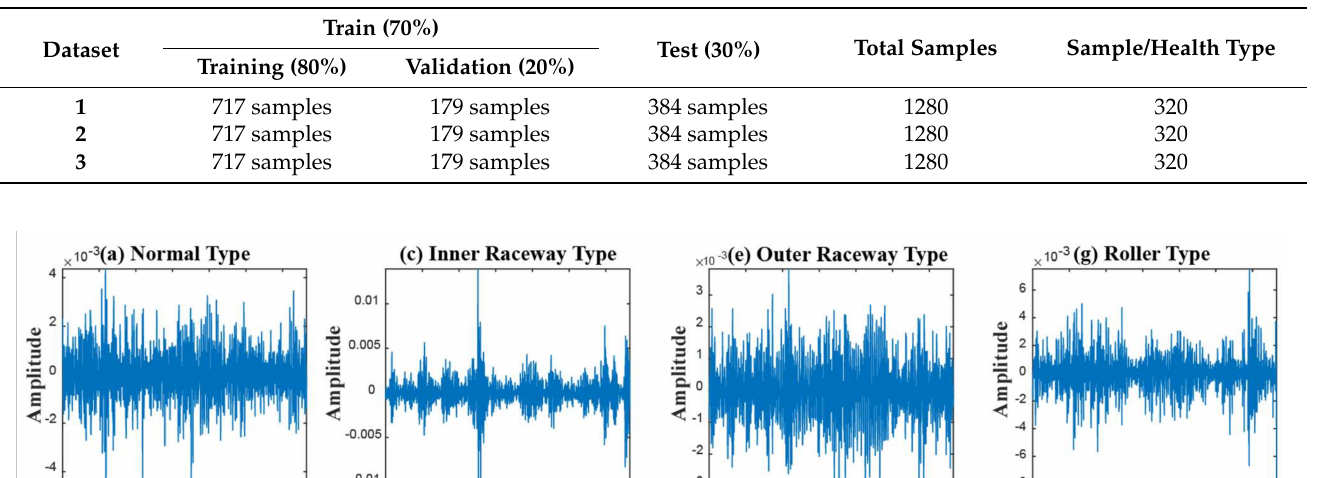
Table 8. Details of the data division.